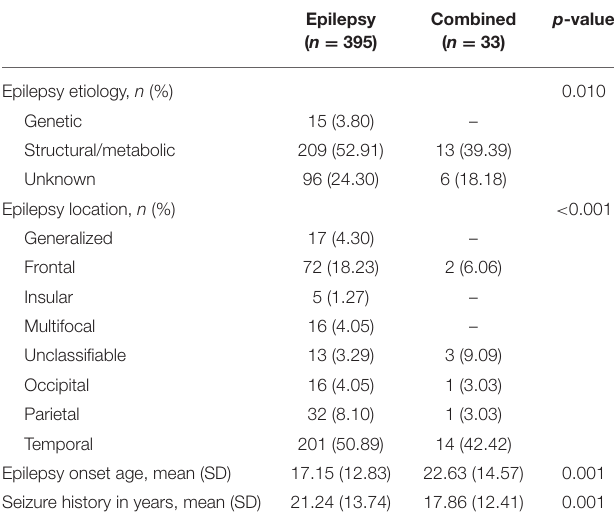
TABLE 3 | Clinical characteristics of the